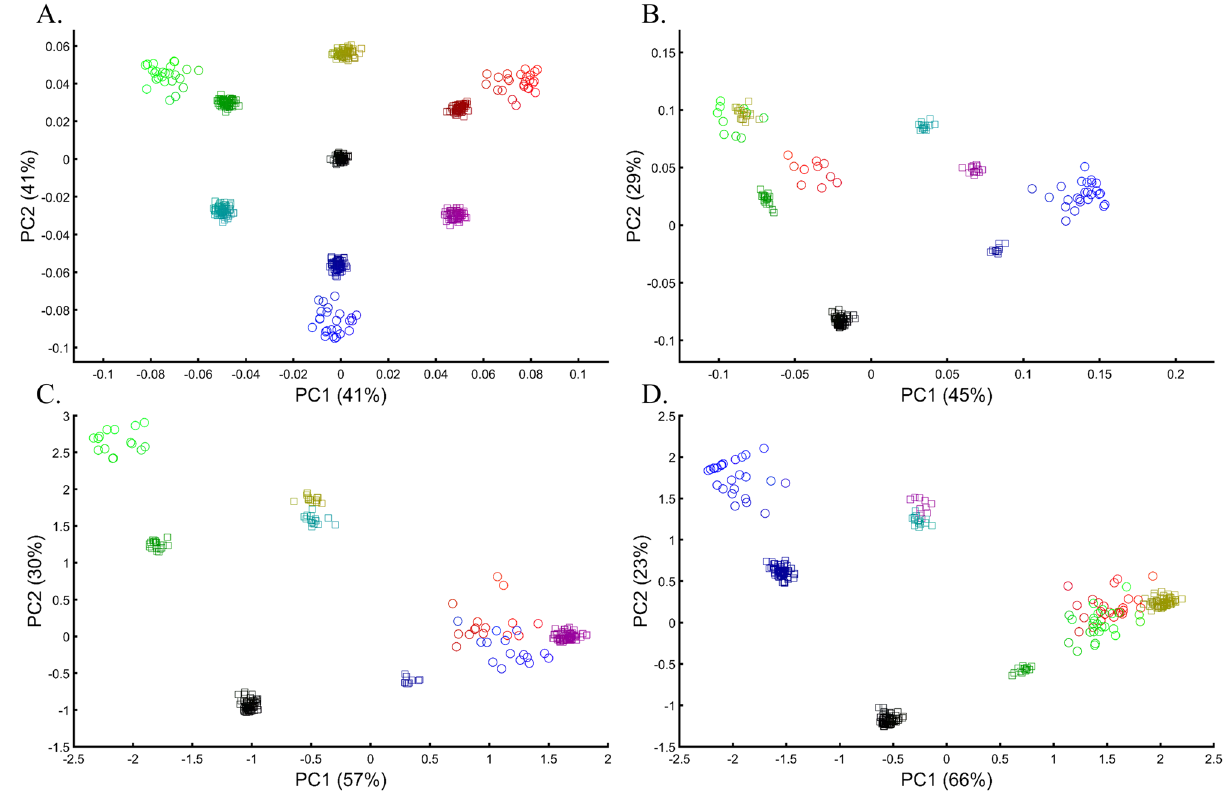
Figure 19. Merging PCA of “ancient” (circles) and “modern” (squares) color populations using two approaches. First, PCA is calculated separately on the two datasets, and the results are plotted together ( A , B ). Second, PCA results of “ancient” populations are projected onto the PCs of the “modern” ones ( C , D ). In ( A ), even-sized samples from “ancient” ( n = 25) and “modern” ( n = 75) color populations are used. In ( B ), different-sized samples from “ancient” (10 ≤ n ≤ 25) and “modern” (10 ≤ n ≤ 75) populations are used. In ( C ) and ( D ), different-sized samples from “ancient” (10 ≤ n ≤ 75) are used alongside even-sized samples from “modern” populations: ( C ) ( n = 15) and ( D ) n = 25. Colors include Red [1,0,0], dark Red [0.6,0,0], Green [0,1,0], dark Green [0,0.6,0], Blue [0,0,1], dark Blue [0,0,0.6], light Cyan [0,0.6,0.6], light Yellow [0.6,0.6,0], light Purple [0.6,0,0.6], and Black